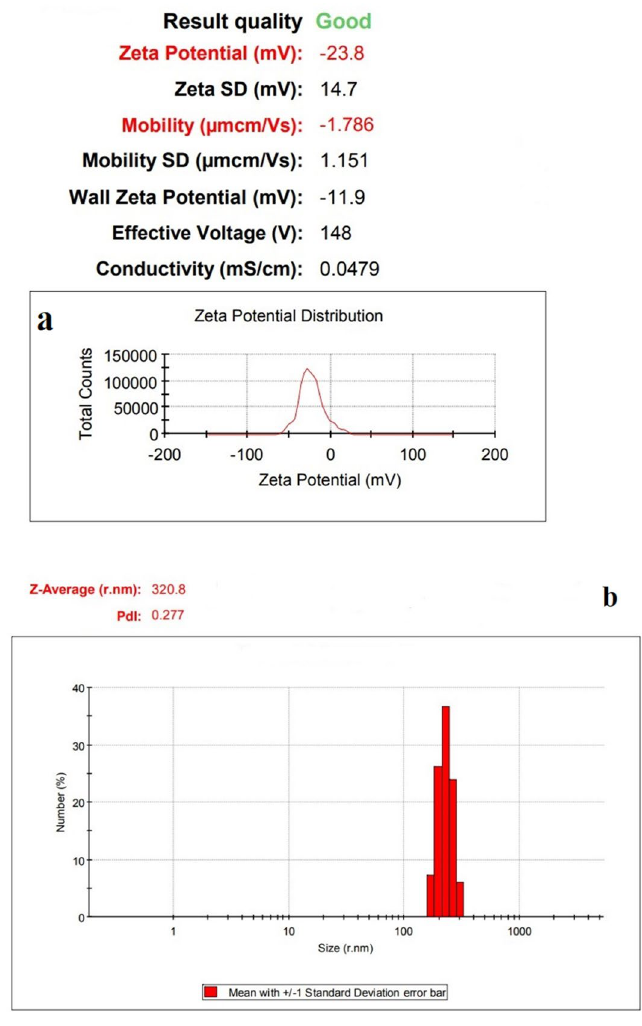
Figure 4. Zeta potential ( a ) and DLS ( b ) analyses of Bi 2 O 3 /Gln-TSC